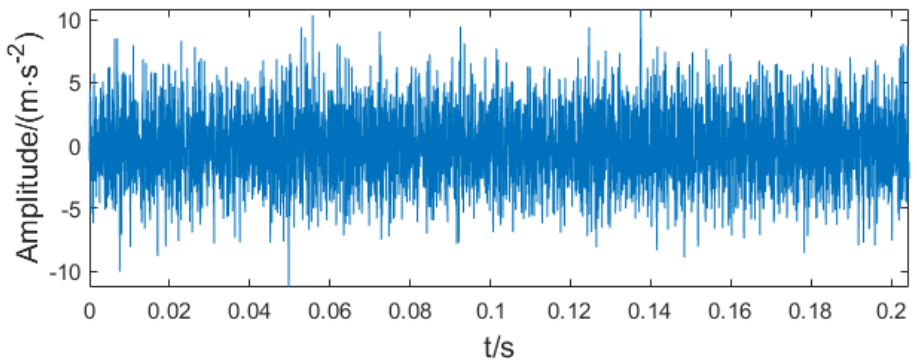
Figure 4. Reconstructed signal of the simulated signal.